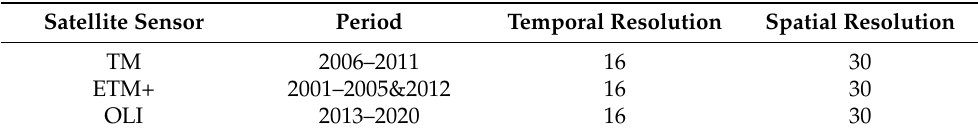
Table 1. Basic information on satellite products.